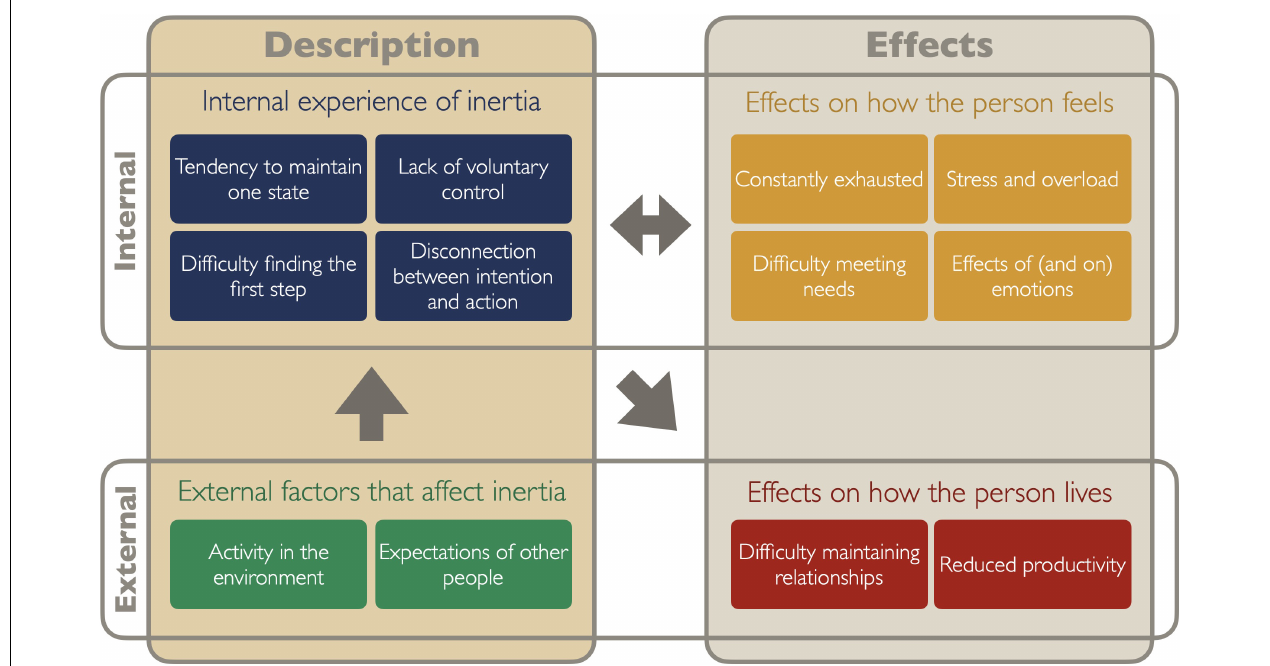
‘inertia’ is used to refer collectively to these related functions, especially when these interfere with initiation of new